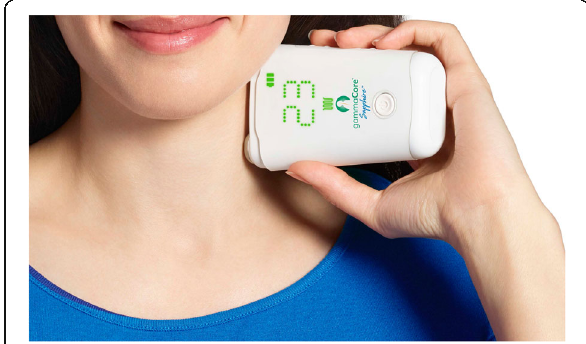
Fig. 1 The Non-invasive Vagus Nerve Stimulation Device. Note: A previous model of the nVNS device was used by patients in the PRospectivE Study of nVNS for the acute Treatment Of migraine (PRESTO) trial. Image provided courtesy of electroCore, Inc. Abbreviation: nVNS, non-invasive vagus nerve